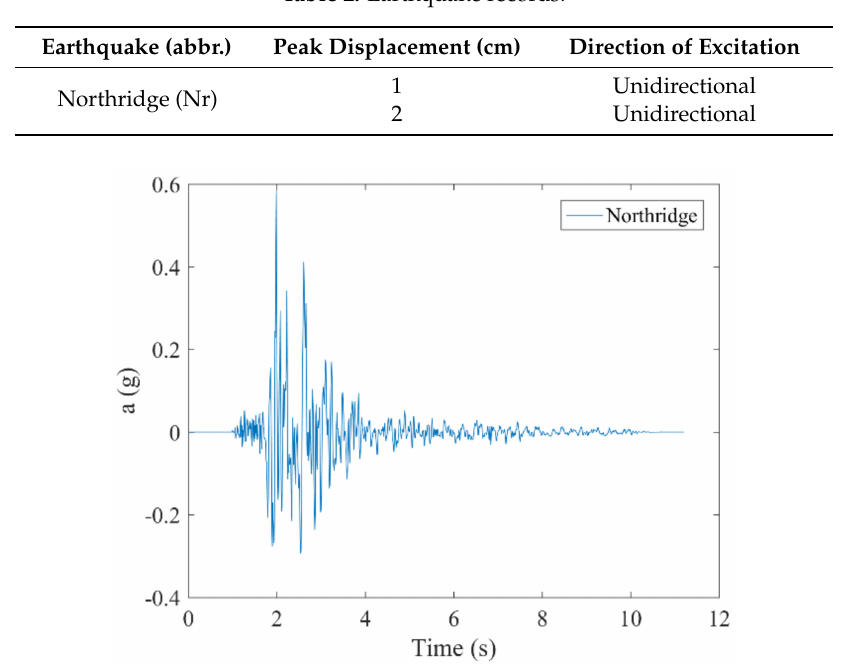
Table 2. Earthquake records.